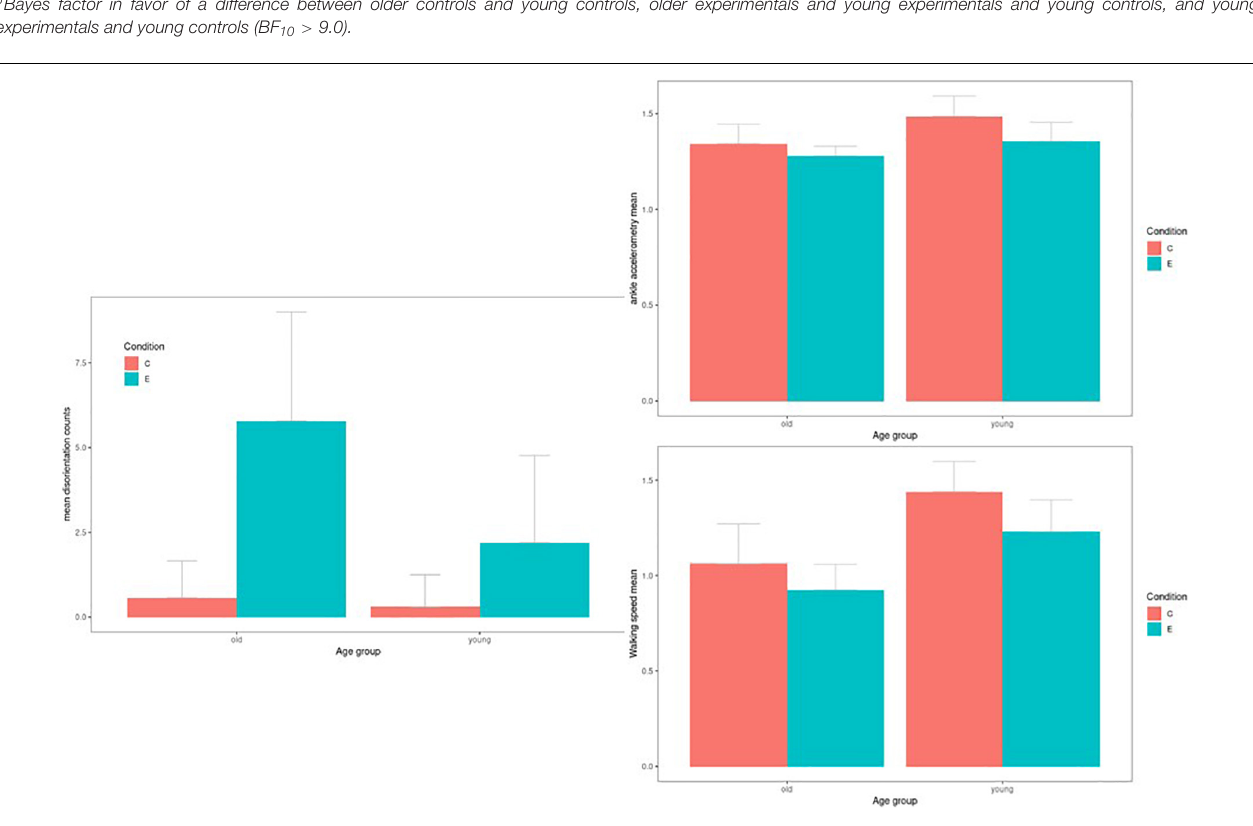
FIGURE 1 | Aggregated disorientation events, accelerometry, and walking speed by age group by condition. Disorientation events (upper row), ankle worn accelerometric signal (middle row), and walking speed mean (lower row) according to age group and condition [control (C) vs . experimental (E)]. Bars show mean and 95% credibility